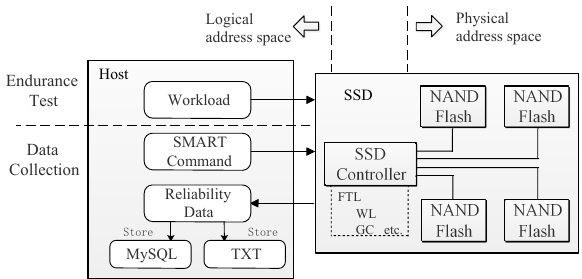
Figure 3. Overview of our measurement flow and data collection.